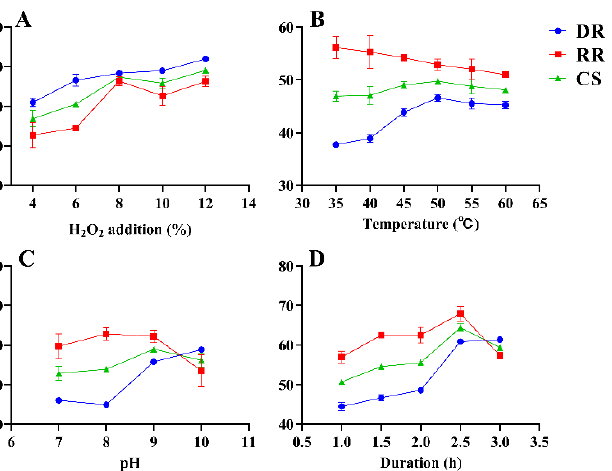
Figure 2. SFEs for the decolorization of RGP using H 2 O 2 . DR: decolorization rate (%); RR: retention rate (%); CS: composite score (%). ( A – D ): H 2 O 2 addition, temperature, pH, duration.